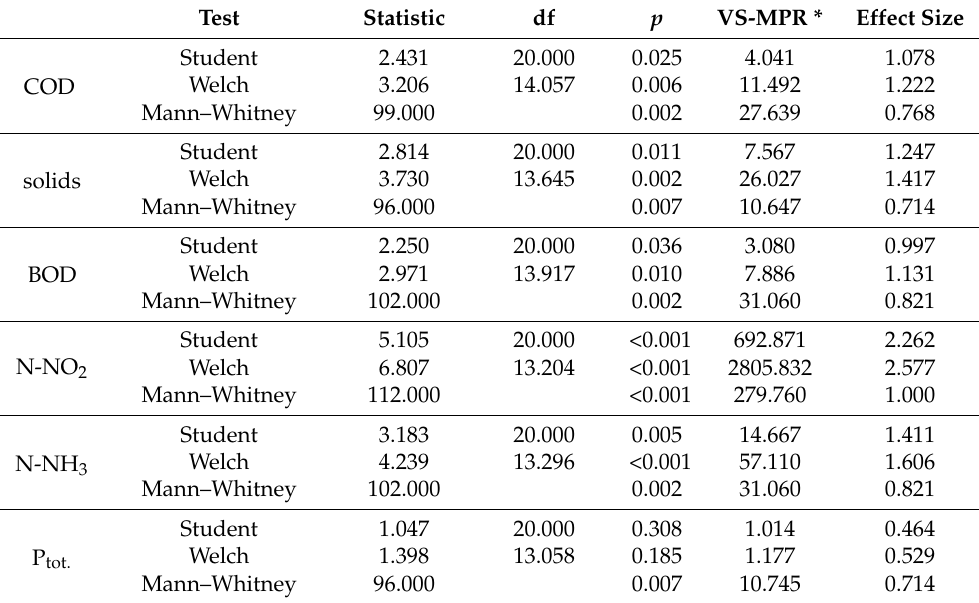
Table 6. Results of independent sample T -test for technological sewage compounds determinations.